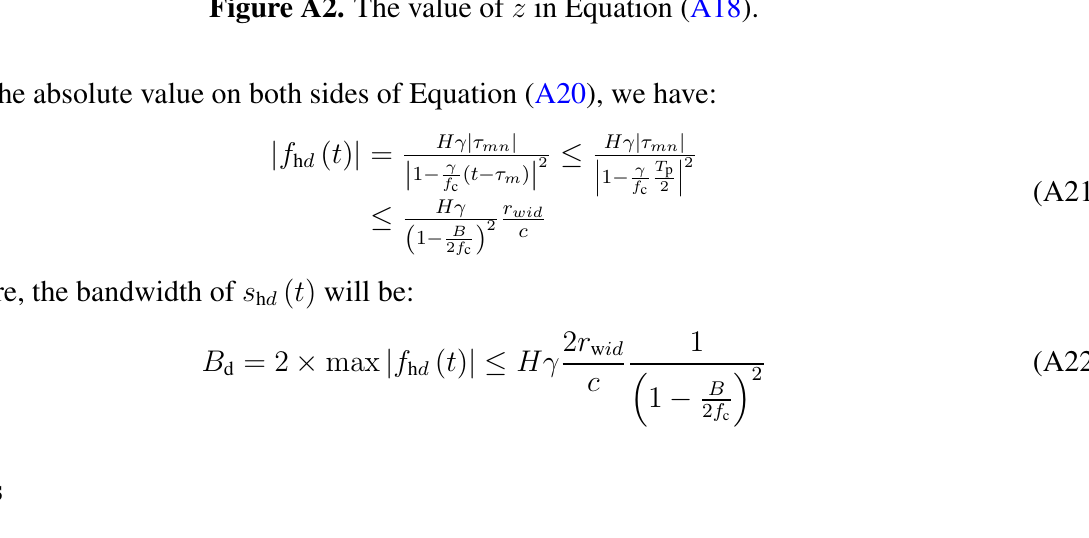
Figure A2. The value of z in Equation